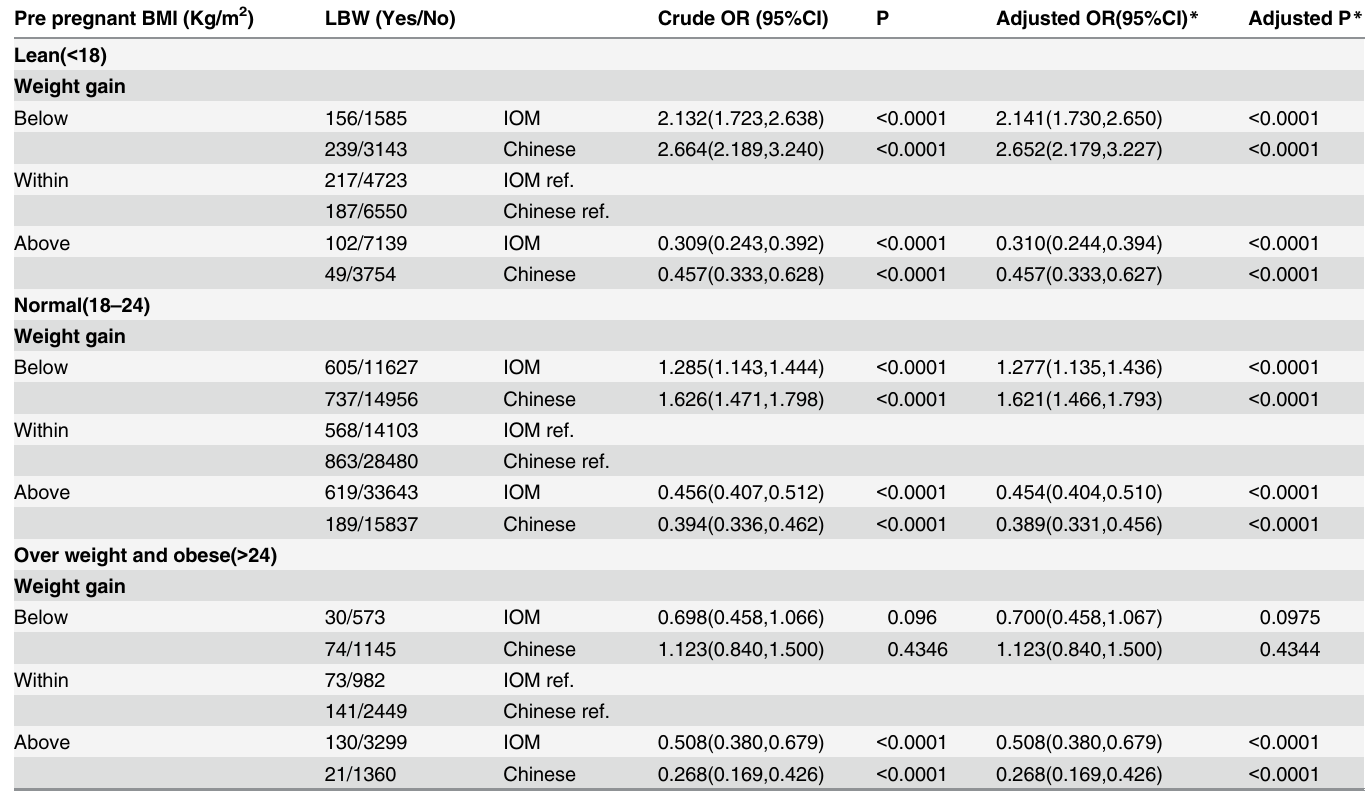
Table 4. ORs for LBW by weight gain and pre pregnant